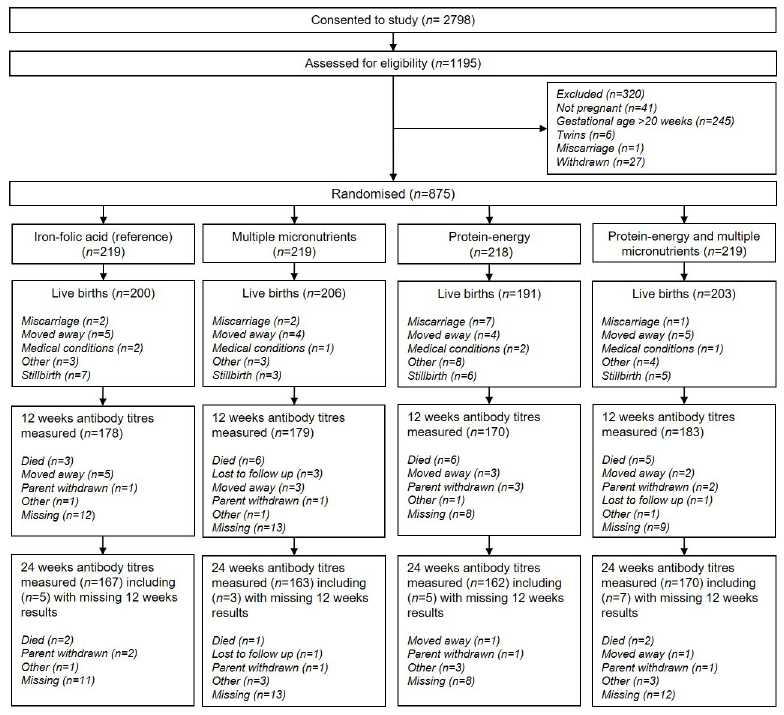
Fig 1. Flow diagram of the trial. CONSORT diagram presenting the flow of participants in the trial. A miscarriage was defined using the WHO definition of the premature loss of a fetus up to 23 weeks of pregnancy. CONSORT, Consolidated Standards of Reporting Trials; FeFol, iron-folic acid; MMN, multiple micronutrients; PE, protein-energy.